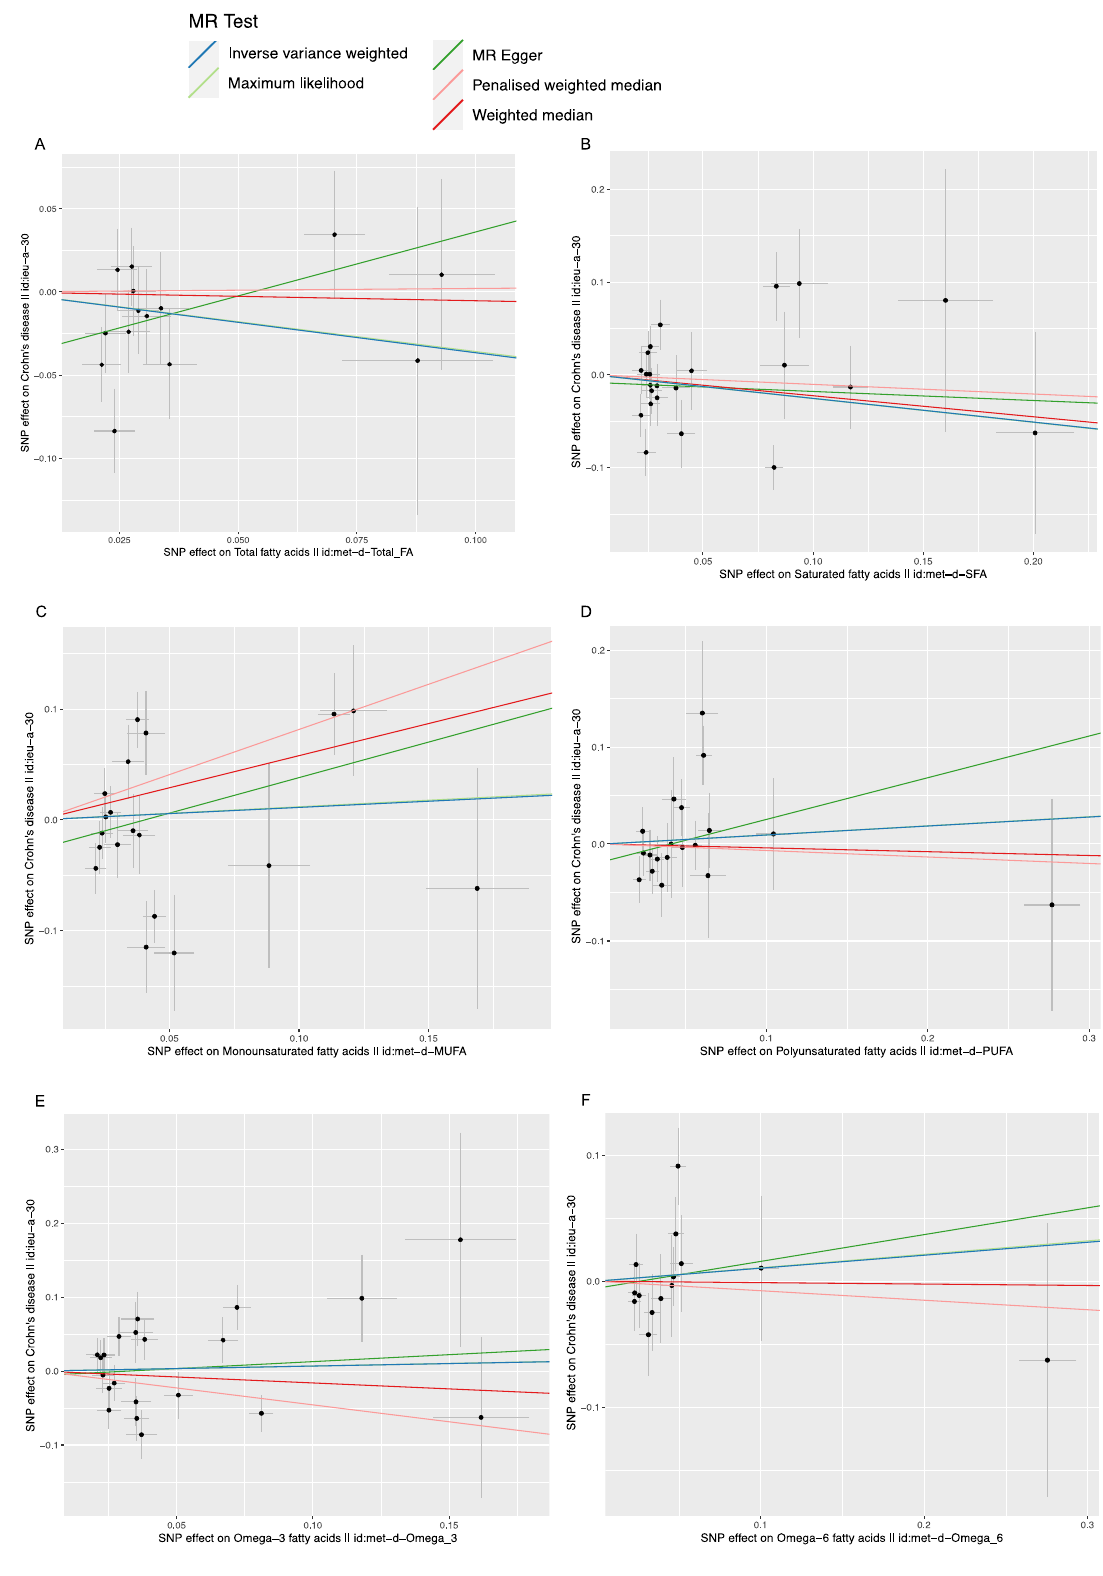
Figure 3. The scatter plot of fatty acids (FAs) and Crohn’s disease (CD). X axis, the single nucleotide polymorphism (SNP) effect and SEs (standard errors) on each of the selected SNPs from FA Genome-wide summary association study (GWA) datasets. Y axis, the SNP effect and SEs on CD from CD Genome-wide summary association study (GWA) datasets. ( A ) Analysis of Total FA and CD; ( B ) Analysis of saturated FA and CD; ( C ) Analysis of monounsaturated FA and CD; ( D ) Analysis of polyunsaturated FA and CD; ( E ) Analysis of Omega-3 FA and CD; ( F ) Analysis of Omega-6 FA and